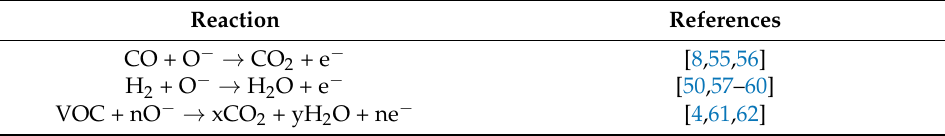
Table 1. Reactions of common reducing gases with ionosorbed oxygen. Reaction